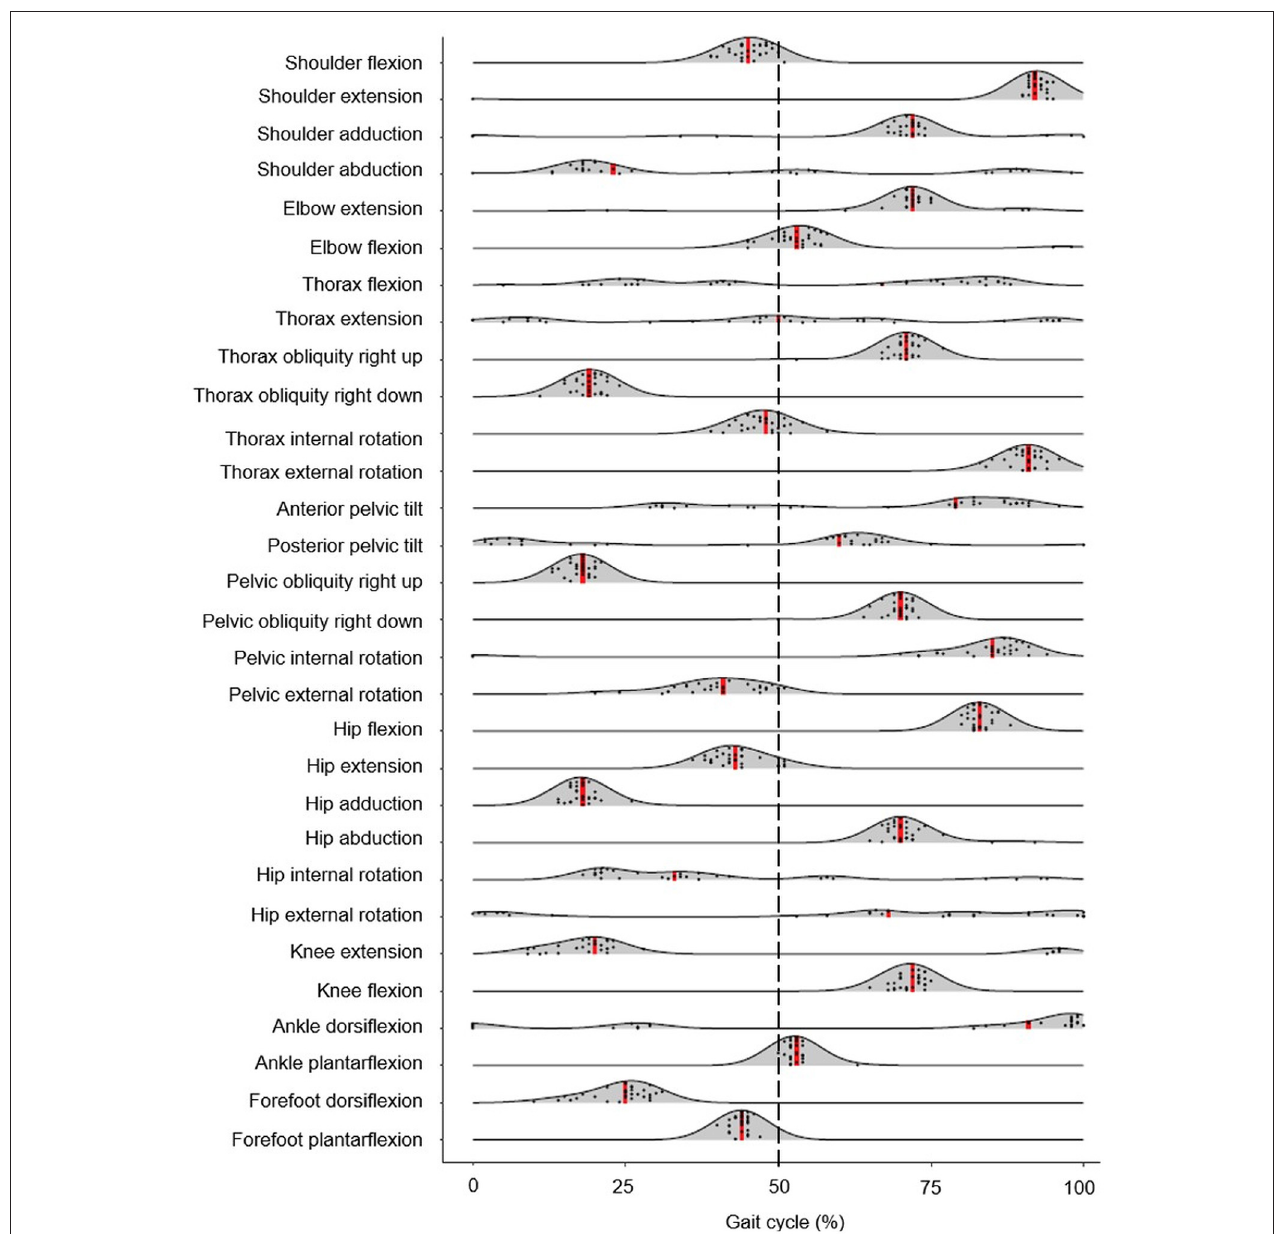
FIGURE 2 | Density ridgeline plot of the timing of each joint angle peak during the gait cycle. Individual variation is dotted, and median values are represented by red vertical lines. The dashed vertical line represents gait cycle division between stance (from 0 to 50%) and swing (from 51 to